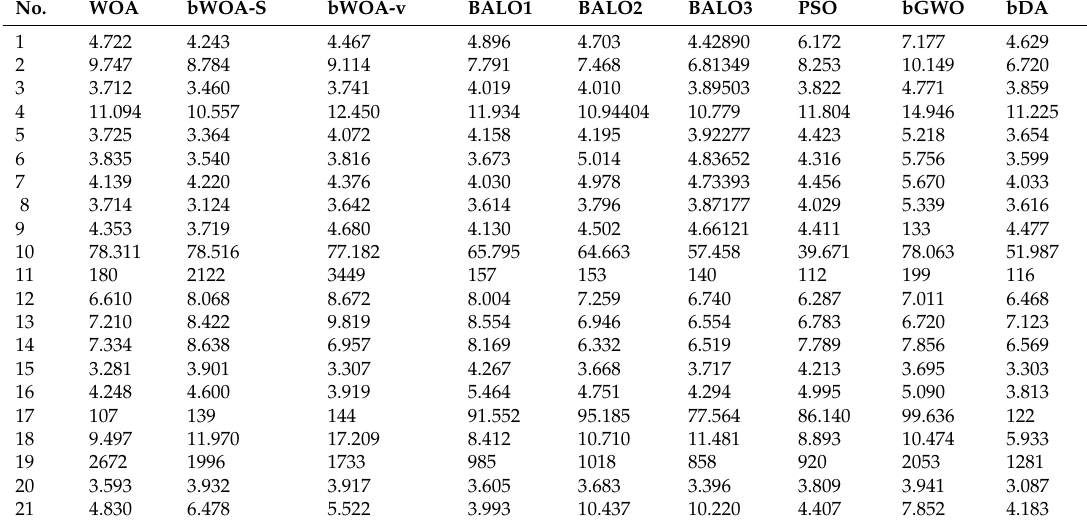
Figure 3. Statistical mean fitness averaged on the different datasets for the different optimizers using the different initializers. Table 11. Average execution time in seconds on the different datasets for the compared algorithms averaged over the three initialization